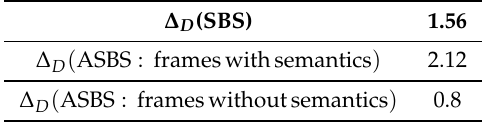
Table 3. Mean computation time ∆ D (ms/frame) of SBS and